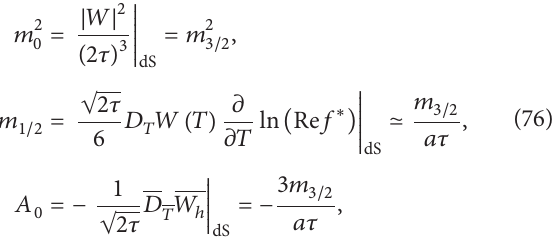
below in the limit 𝜏 5 → ∞ and 𝜏 4 ∝ log ( V ) . Namely, in the latter limit, the potential has the form 𝑊 2 𝑉 =